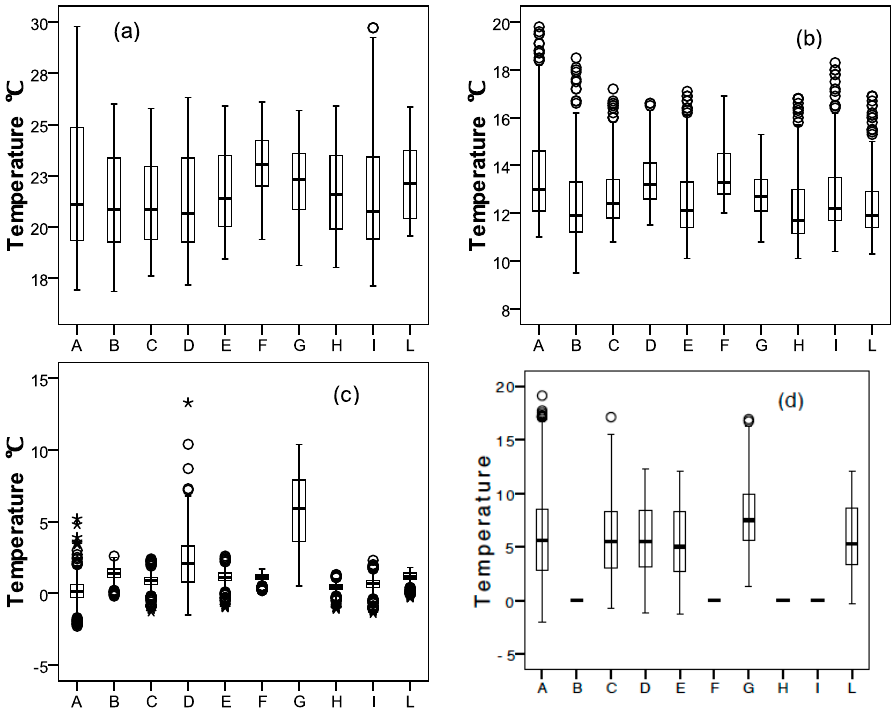
Figure 13. Quartile graphs of interior and exterior air temperatures: ( a ) 22–28 August 2011 (summer); ( b ) 12–20 April 2012 (transition season); ( c ) 15–21 February 2014 (extreme weather in winter); and ( d ) 23 January to 18 February 2013 (long-term winter period).